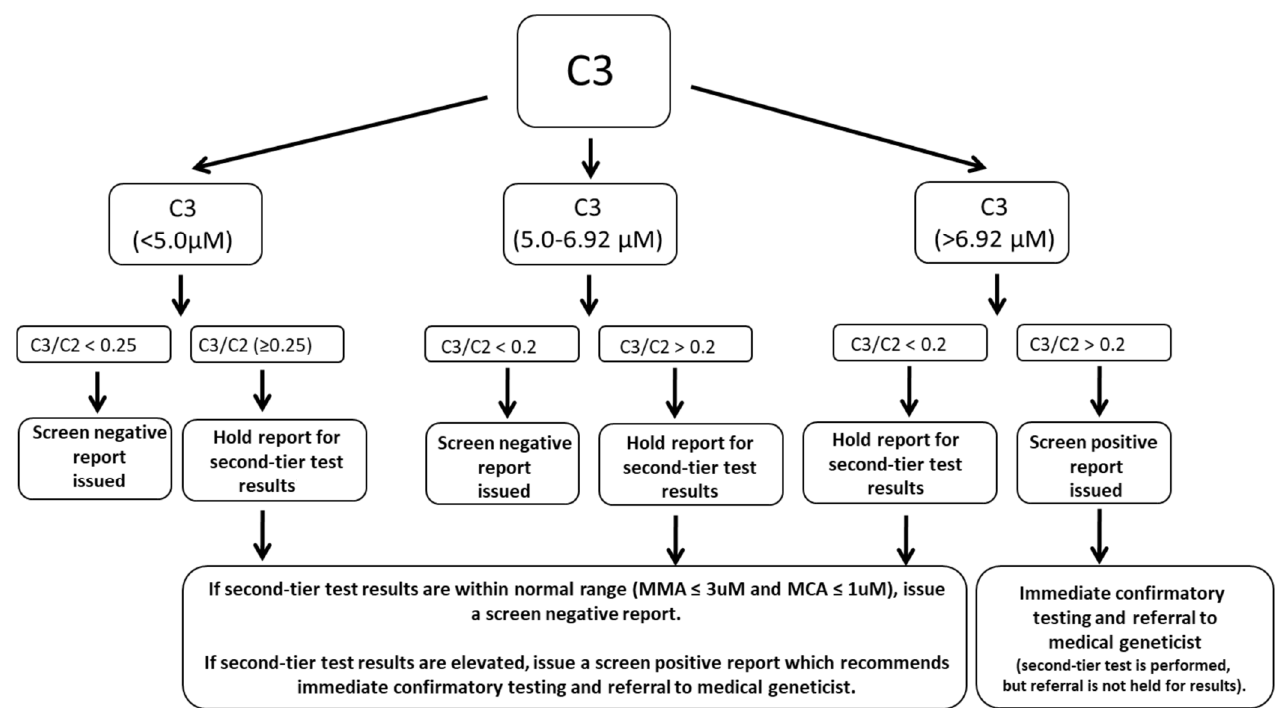
Figure 1. Wisconsin newborn screening algorithm for elevated propionylcarnitine (C3).